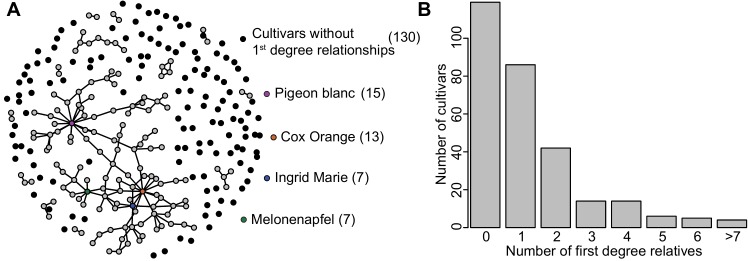
Pedigree structure in the Danish apple germplasm collection.(A) Network of first-degree relationships for each of the 272 unique Malus domestica cultivars. Each unique apple cultivar is represented by a dot and edges in the network represent first-degree relationships. Cultivars without first-degree relationships in the collection are indicated by a lone, black dot. In total, 142 cultivars have at least one first-degree relationship. The largest interconnected network includes 106 (39%) of the unique cultivars that are connected through a series of first-degree relatives. (B) The number of first-degree relationships for each of the 272 cultivars. While 130 (48%) cultivars are without first-degree relationships, 52% of the cultivars have a first-degree relationship with at least one other accession.